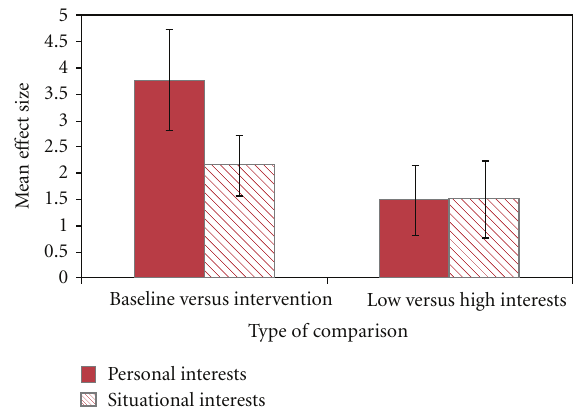
Figure 1: Average e ff ect sizes and 95% confidence intervals for incorporating either personal or situational child interests into the interest-based interventions ( Z s = 4 . 60 to 7 . 87, P = . 0000 for all average e ff ect